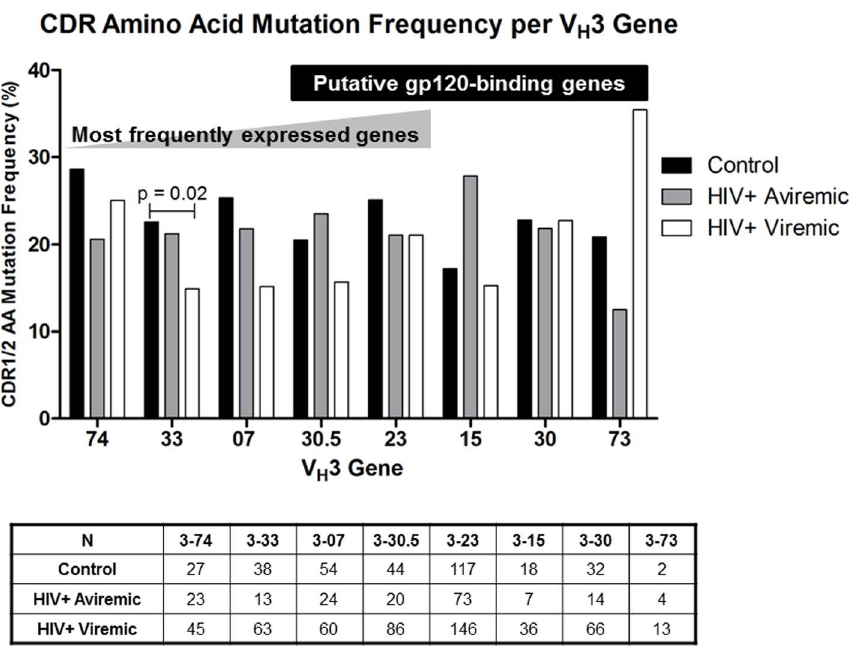
Figure 4. Frequencies of amino acid replacement mutations in specific V H 3 genes. The group median for CDR1/2 in each of the 5 most frequently expressed V H 3 genes (V H 3-74, -33, -07, -30.5, and -23) and for the V H 3 genes proposed to bind to HIV-1 gp120 outside of the antigen binding region (V H 3-30.5, -23, -15, -30, and -73) are calculated from the mean mutation frequencies for each individual subject in control (n=10; black bars), aviremic (n=6; gray bars), and viremic groups (n=15; white bars). The table below shows the total number of sequences cloned (N) for each gene by group. P values were calculated for each gene. Only the overall p value for V H 3-33 was significant (p=0.02). Secondary analyses: control vs. viremic p , 0.05; all other comparisons p .